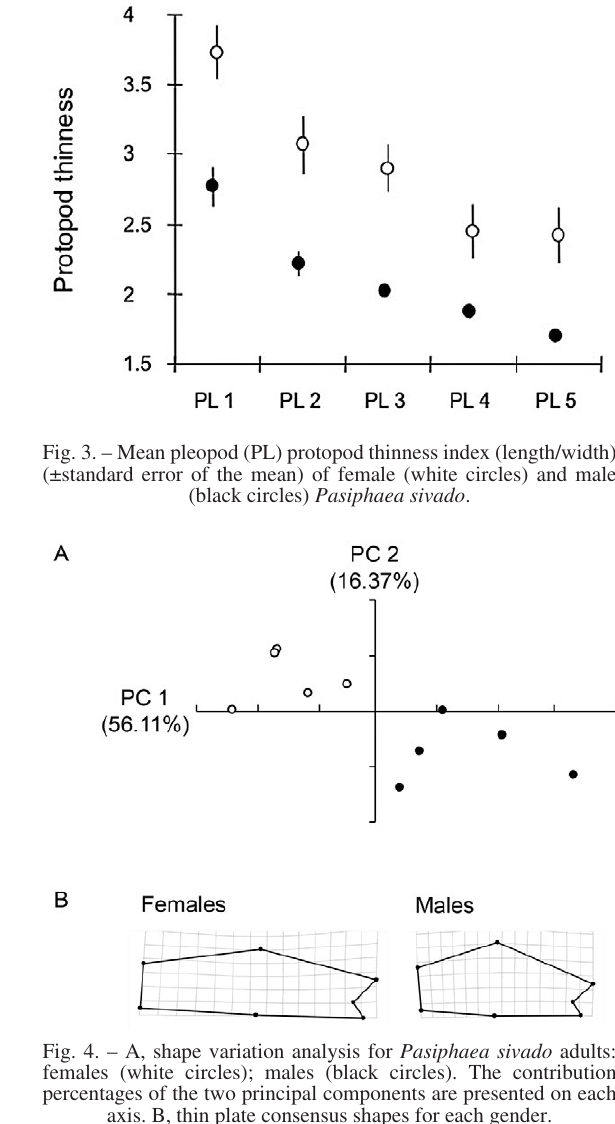
Table 1. – Number of individuals examined (N), mean, standard deviation (±SD), maximum (max) and minimum (min) length (L) and width (W) of the pleopod protopod (PL1-5, first to fifth), and mean ratio L/W of adult Pasiphaea sivado females (CL (CL =21.6-24.0 mm). Significance of differences of the L/W ratio between genders is also shown in the the last column of the first table. range N